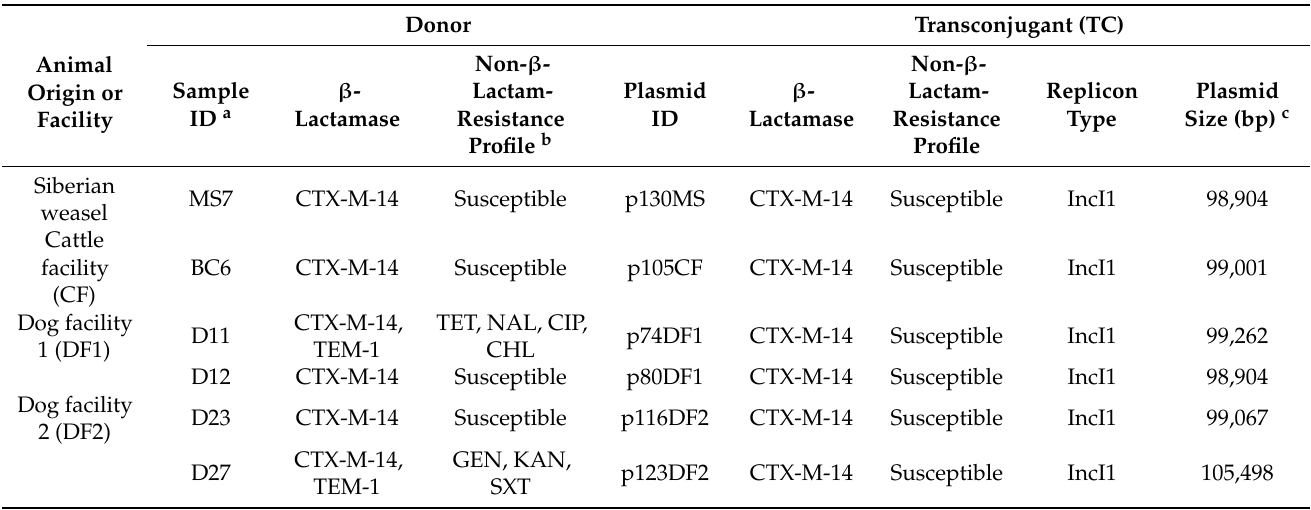
Table 2. Characteristics of six donor isolates carrying CTX-M-14 plasmids and their transconjugants based on pulsed-field gel electrophoresis (PFGE) profiles.